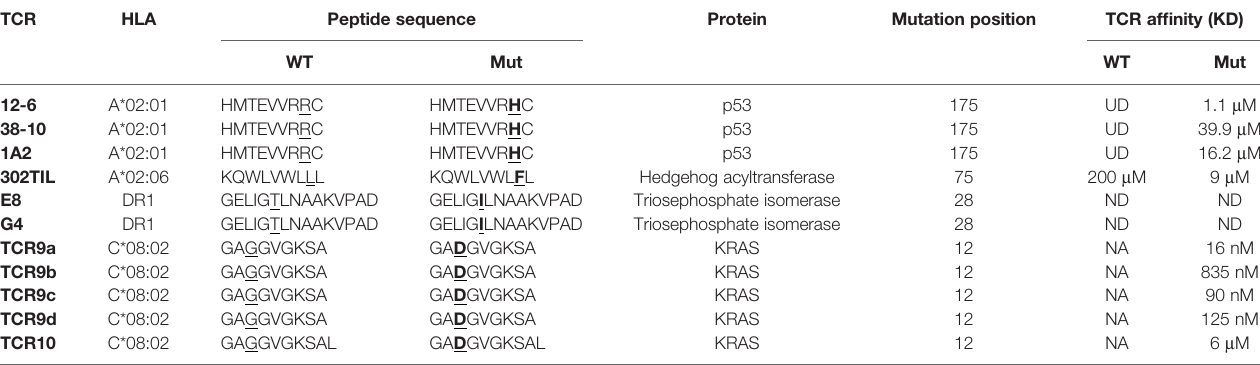
TABLE 1 | Neoantigen speci fi c TCRs with crystal structures.